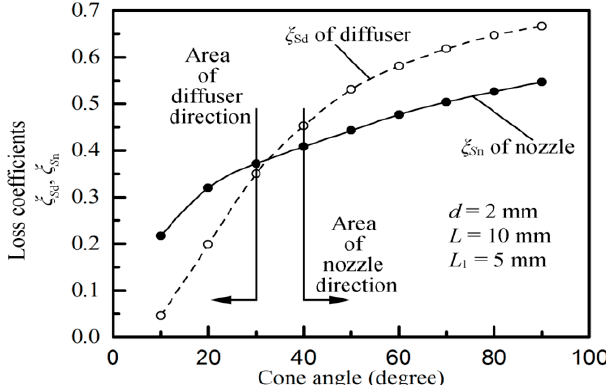
Figure 4. Empirical curves of the cone angle, the diffuser loss coefficient ξ Sd , and the nozzle loss coefficient ξ Sn . ( d, L, L 1 is defined in figure 4 in references [44].)